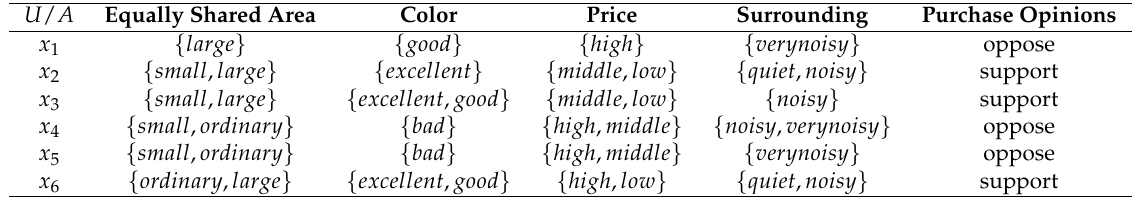
Table 1. A decision system of a house evaluation